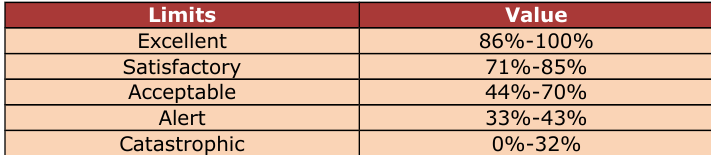
Table 4. Limit values between states in green procurement criterion